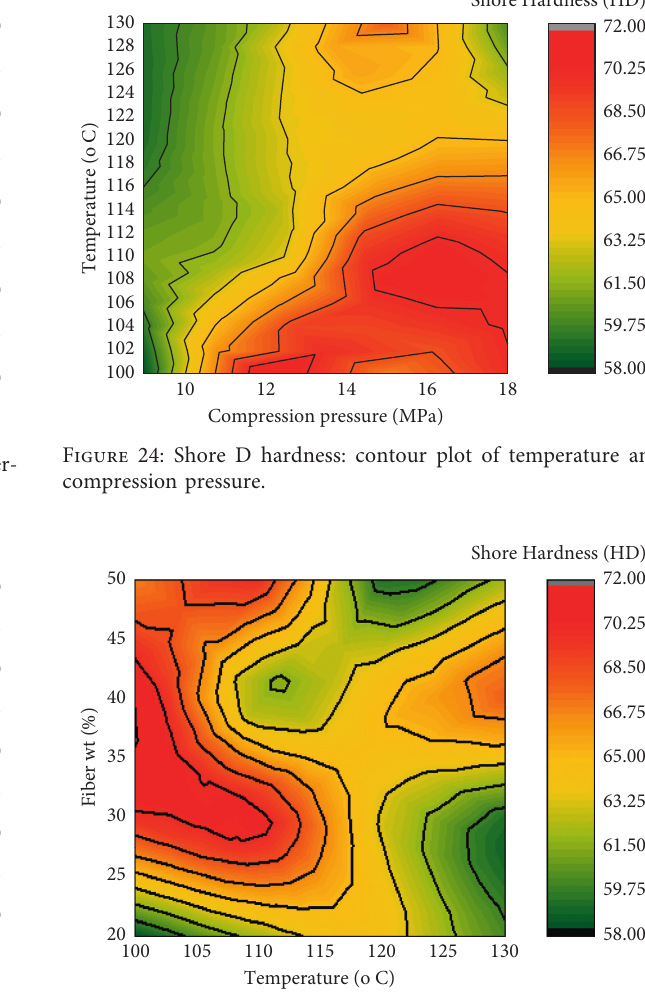
Figure 25: Shore D hardness: contour plot of fiber weight per- centage and